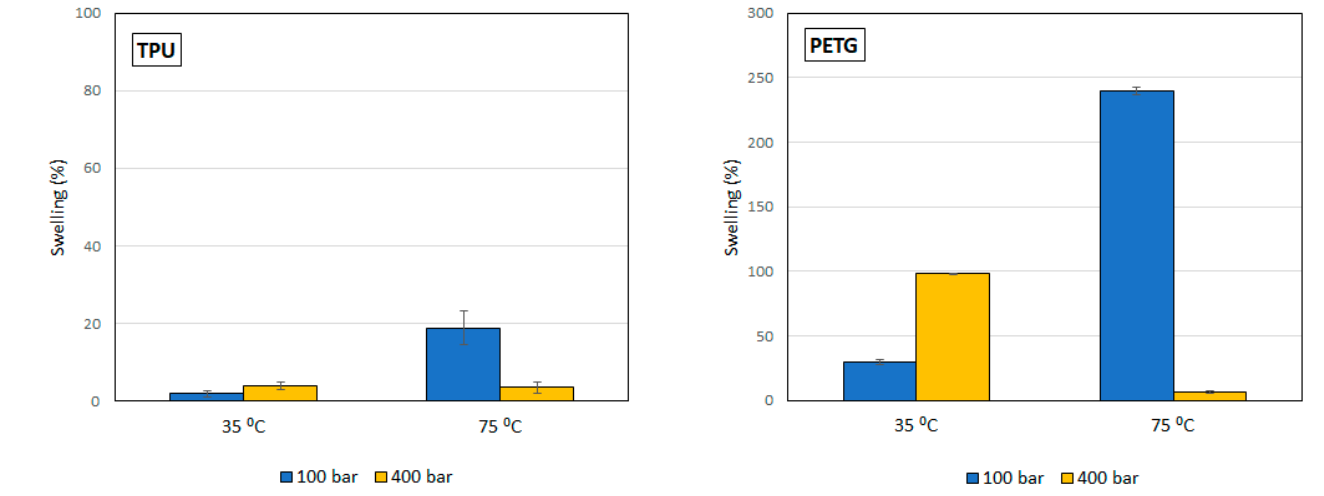
Figure 4. Swelling of the polymers in the supercritical solvent impregnation of MLE. Table 1. ANOVA table and Pareto chart for quadratic model of swelling of PETG in the SSI with MLE. Sum Sq Df Mean Sq F-Value p -Value